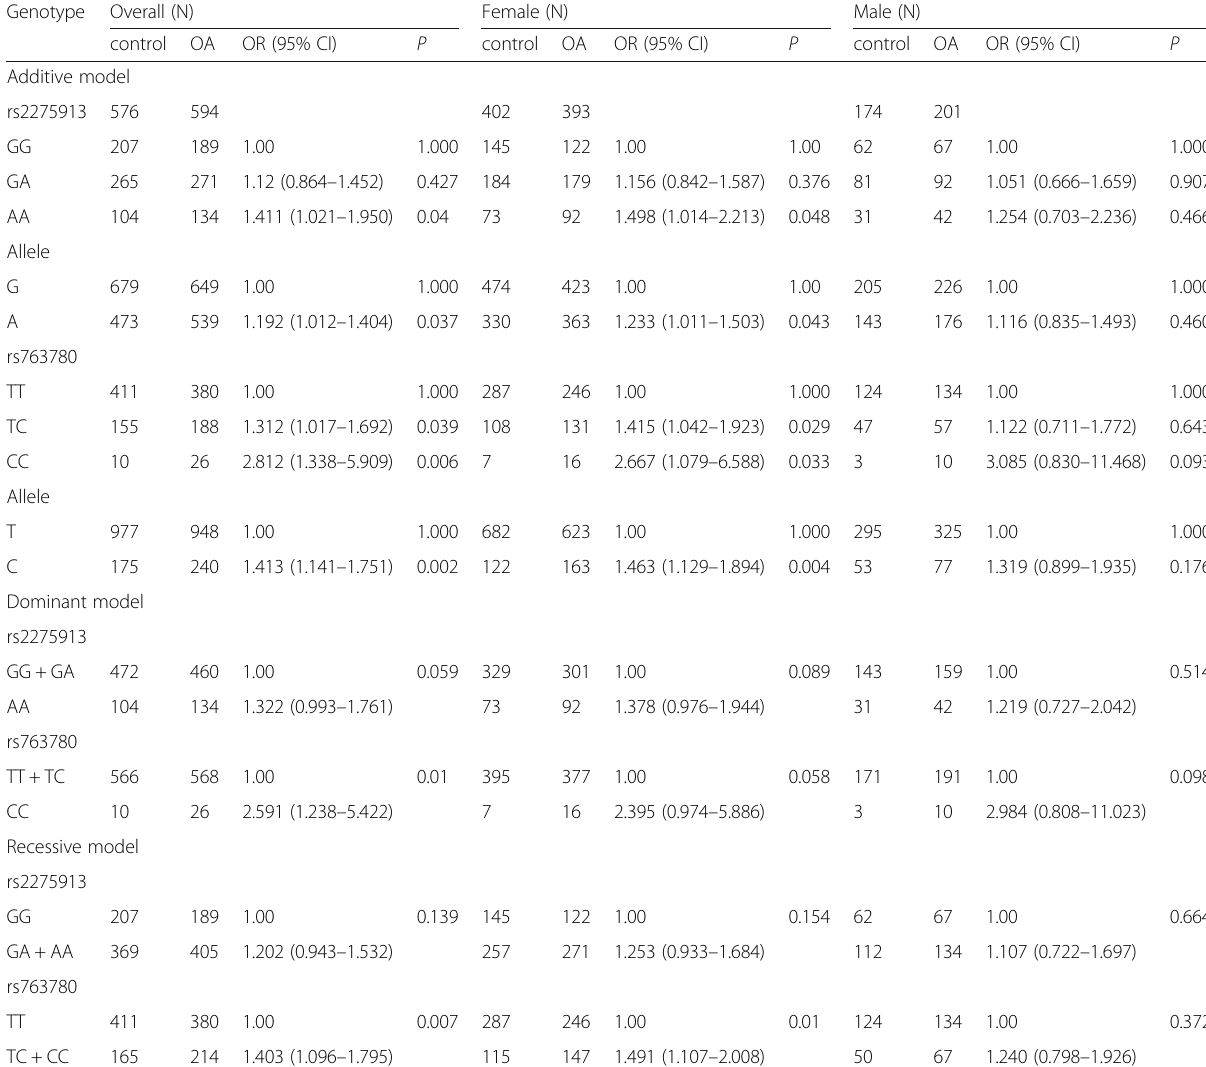
Table 2 Distributions of IL-17 SNPs genotypes in each group and analyses of associations between these polymorphisms and knee OA risk